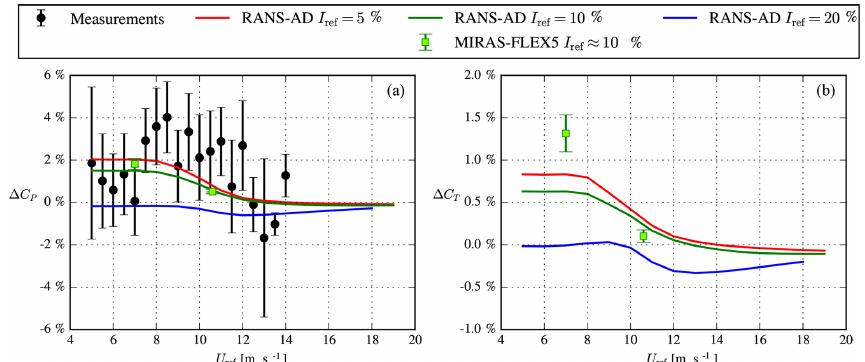
Figure 10. Relative difference between the 4R-V29 wind turbine with all rotors in operation and the 4R-V29 wind turbine with a single rotor in operation, in terms power and thrust as function of the free-stream velocity at a height of 44.27m.